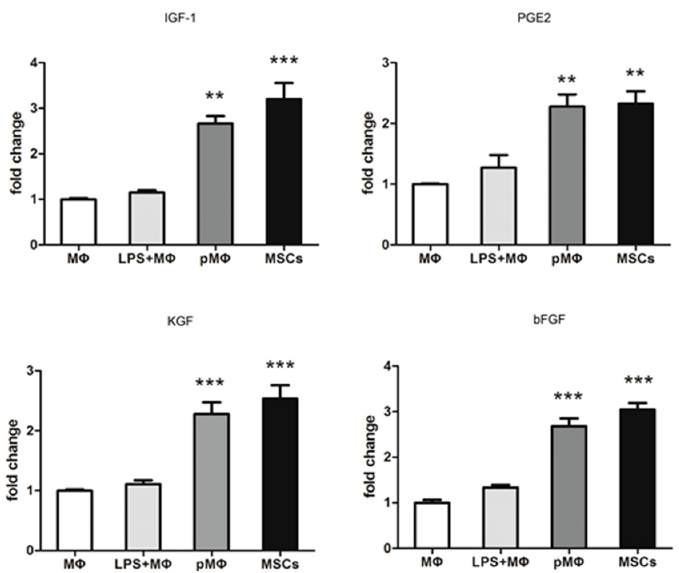
Figure 3. Growth factors were secreted by the cell of M Φ , LPS+ M Φ , pM Φ , and MSCs. Compared to M Φ , all growth factors (Insulin like Growth Factor-1 (IGF-1), Phenyl Glycidyl Ether2 (PGE2), Keratinocyte Growth Factor (KGF), bFibroblast Growth Factor (bFGF)) showed significantly higher expression in pM Φ , and the results were similar or approaching that of the MSCs (** p < 0.01, *** p < 0.001). Each bar represents the mean value ±SD of triplicate results, which means three independent experiments were done.